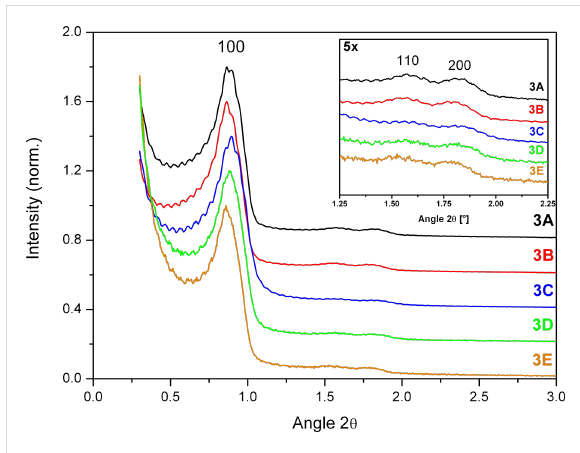
Figure 10: XRD of SBA-15 sample 3 devided into a 1× half batch unwashed ( 3A ), after washing with 5 mL ( 3B ) and 30 mL ( 3C ), a 3× half batch washed with 120 mL ( 3D ) and a 9× half batch washed with 350 mL ( 3E ) quantities of solvent. The intesities are normalized to the (100) reflection and offset by 0.8 ( 3A ), 0.6 ( 3B ), 0.4 ( 3C ) and 0.2 ( 3D ). Note: Oscillations are an artefact in the measurement.